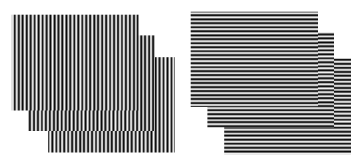
Figure 5. A set of three phase shift patterns